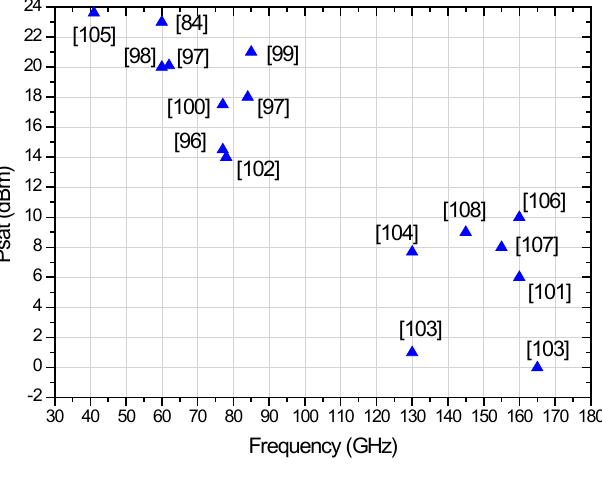
Figure 7. Saturation power of the recent published MMW SiGe PAs. Data taken from